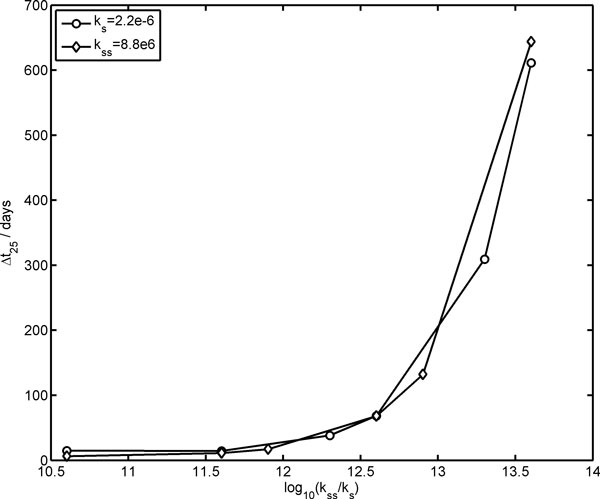
Influences of kss and ks kinetic constants on the Ribocell stationary regime. Life time Δt25 after 25 generations is reported against the log10 of the thermodynamic constant of RNA dimerization. The legend displays the value of the kinetic parameters kept constant.